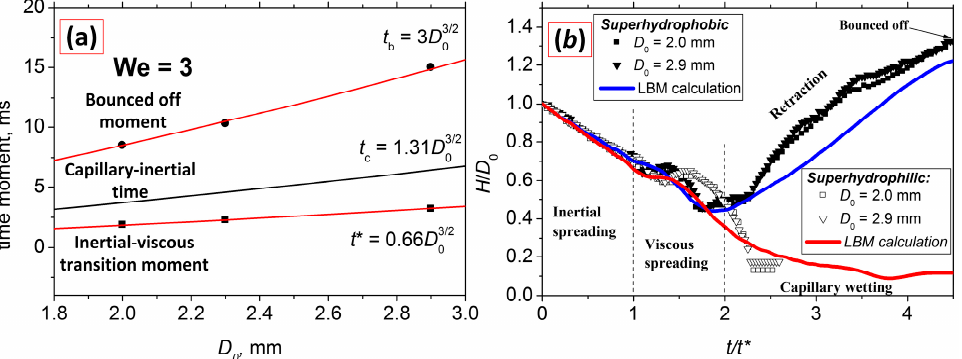
Figure 5. ( a ) Dependence of time t* , capillary ‐ inertial time t c , and droplet rebound moment t b on the diameter. ( b ) Comparison of experimental results for D 0 = 2 and 2.9 mm in relative coordinates, We = 3.